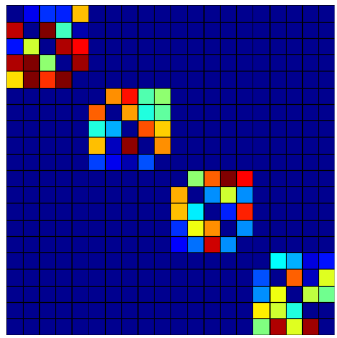
Fig. 1 Example ideal coefficient matrix W in Eq. (3), assuming that each successive 5 data samples come from the same subspace of a union of 4 subspaces, and that they are stacked as adjacent columns of the data matrix A . Each column contains coefficients representing a sample. The elements on the primary diagonal and at positions corresponding to the other 3 subspaces are